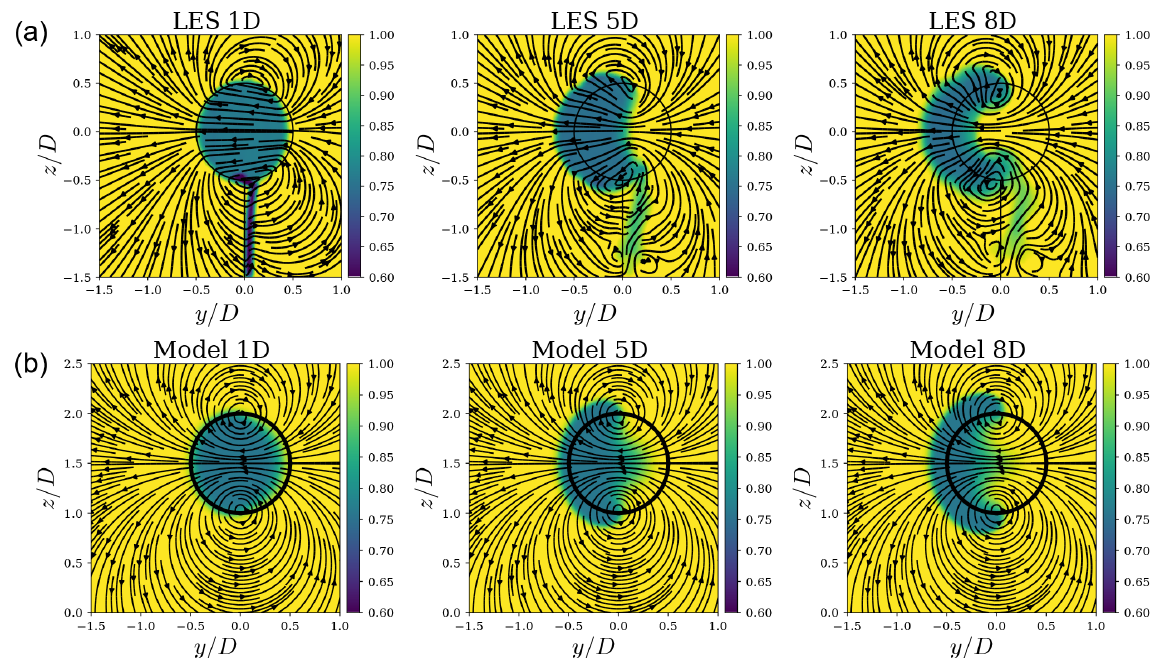
Figure 2. Comparison of streamwise velocity contours between a large-eddy simulation (LES) using an actuator disk model without rotation under uniform inflow from Howland et al. (2016) (a) and the proposed model (b) . The streamlines show the spanwise velocity components.